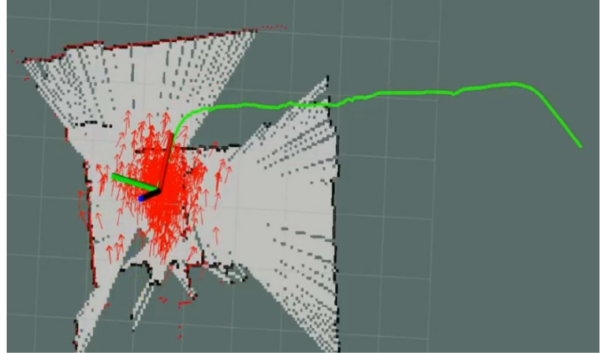
Figure 38. Path planning of the patrol of the second indoor